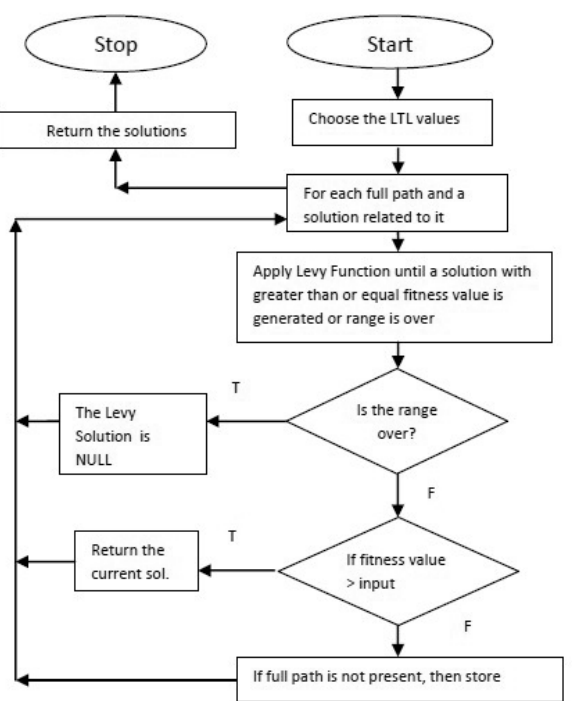
Figure 4. Flow chart of backtracking with Lévy